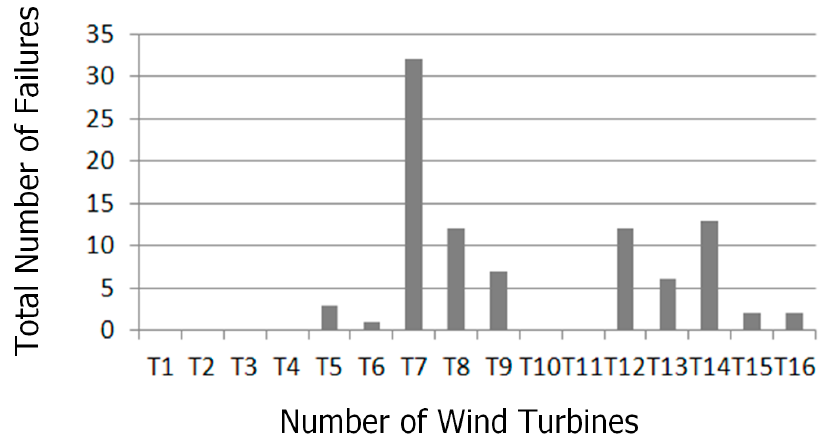
Figure 2. Comparison of the number of yaw gear and motor failures at all the wind turbines.